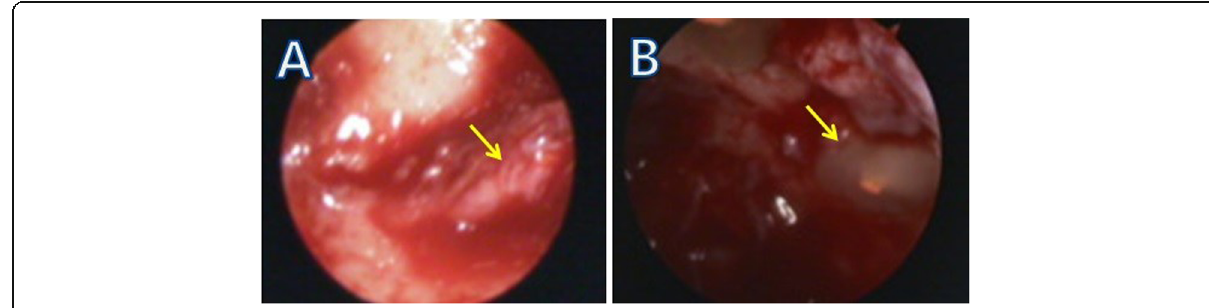
Fig. 3 Endoscopic view of the radicular cyst enucleation site. A Epithelial remnants. B The apicoectomy site of the anterior maxillary tooth